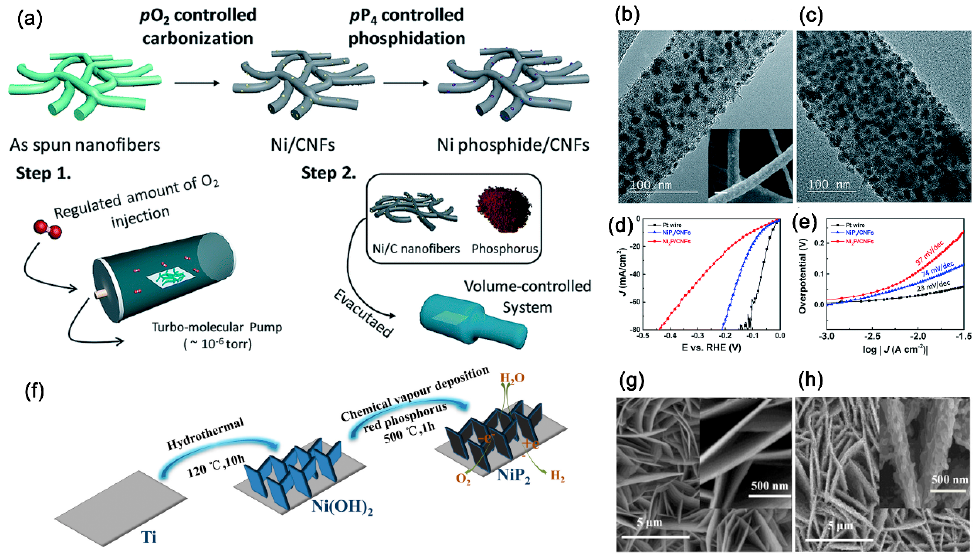
Figure 11. Schematic illustration for the overall synthesis of the Ni phosphide/CNFs ( a ). TEM ( b ) and SEM (insets) images of the Ni/CNFs-O 2 1.0 Torr, TEM image of the Ni phosphide/CNFs-O 2 1.0 Torr ( c ), Polarization curves ( d ), and Tafel plots ( e ) of the Ni 2 P/CNFs, NiP 2 /CNFs, and Pt wire. Reproduced with permission from Reference [51], Copyright the Royal Society of Chemistry, 2019. Schematic illustration of the experimental procedure used for NiP 2 synthesis ( f ), SEM images of Ni(OH) 2 ( g ), and NiP 2 ( h )